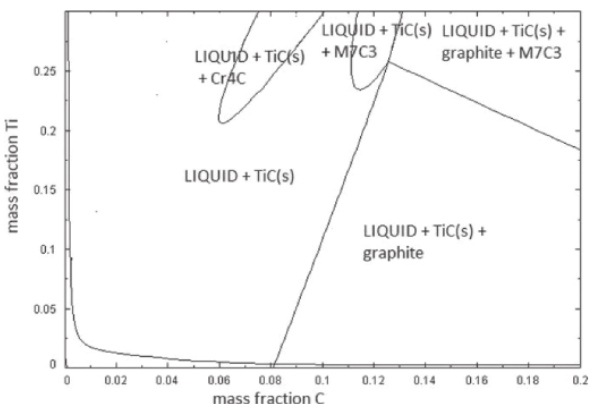
Fig. 15: Fe-Cr25mass%-Ti-C system at 1723